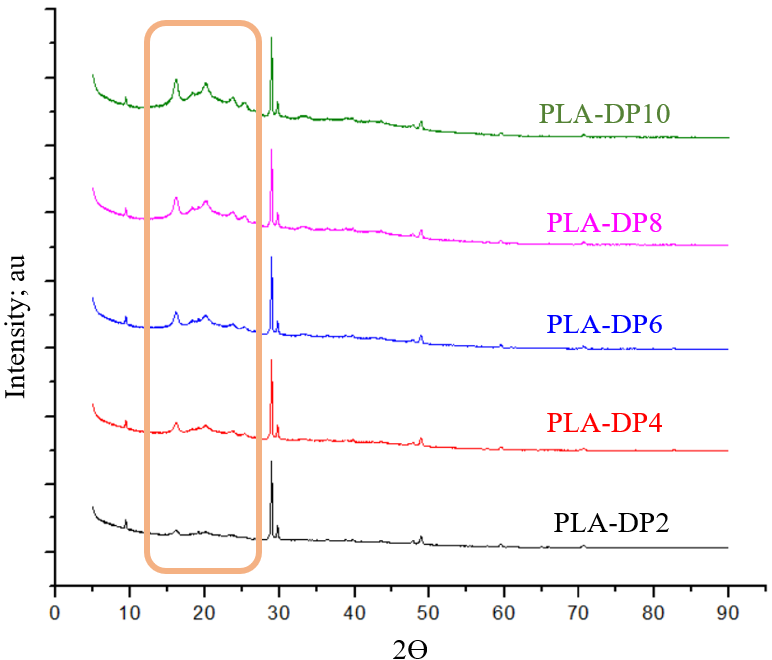
Figure 6. X-ray diffraction (XRD) traces of PLA – date pit composites.